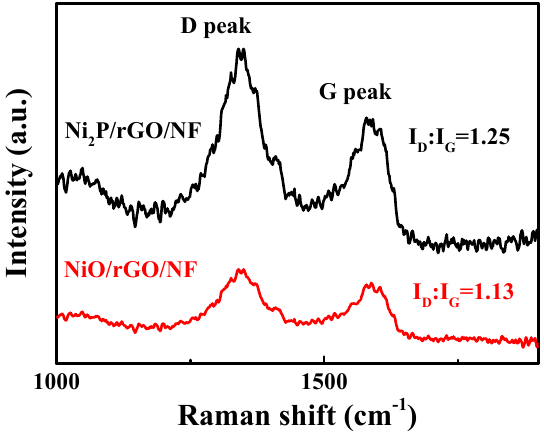
Figure 3. Raman of Ni 2 P/rGO/NF as well as NiO/rGO/NF.